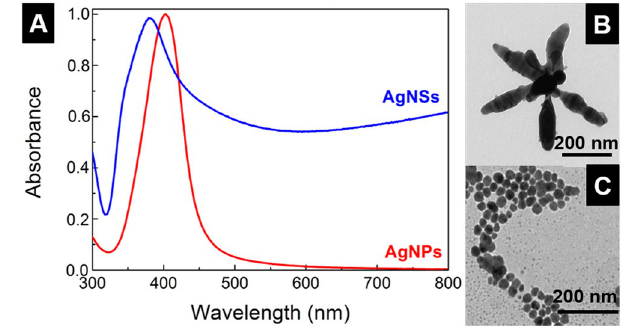
Figure 2. Characterization of AgNPs and AgNSs. ( A ) UV-vis spectra of non-aggregated spherical AgNPs (red) with λ max = 402 nm; and AgNSs (blue) with λ max = 379 nm. Transmission Electron Microscopy (TEM) micrographs showing a ( B ) magnification of a single AgNS; and ( C ) group of